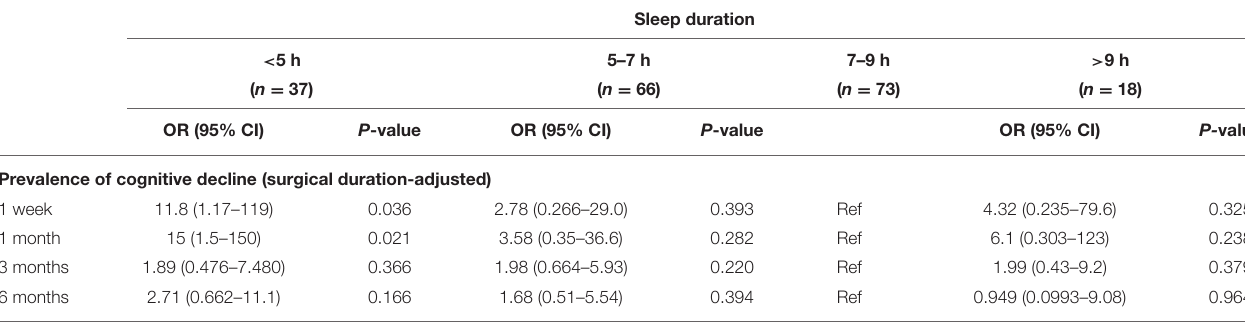
TABLE 3 | Association between sleep duration and prevalence of cognitive decline at each time point.